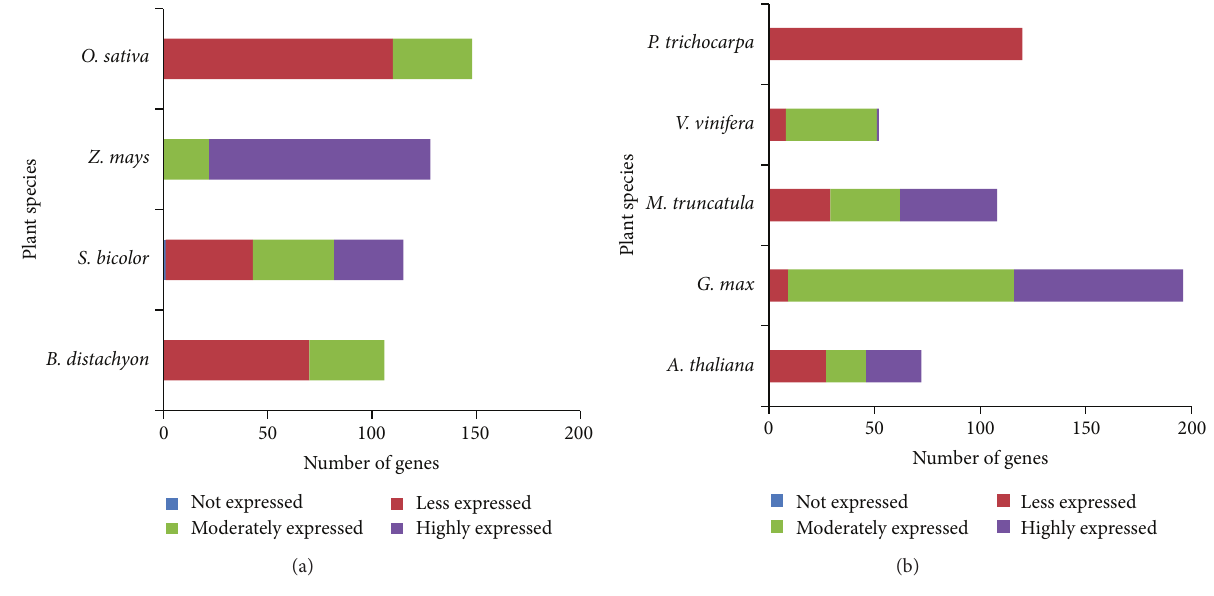
Figure 3: In silico expression analyses of POX A genes in (a) monocots and (b) dicots.